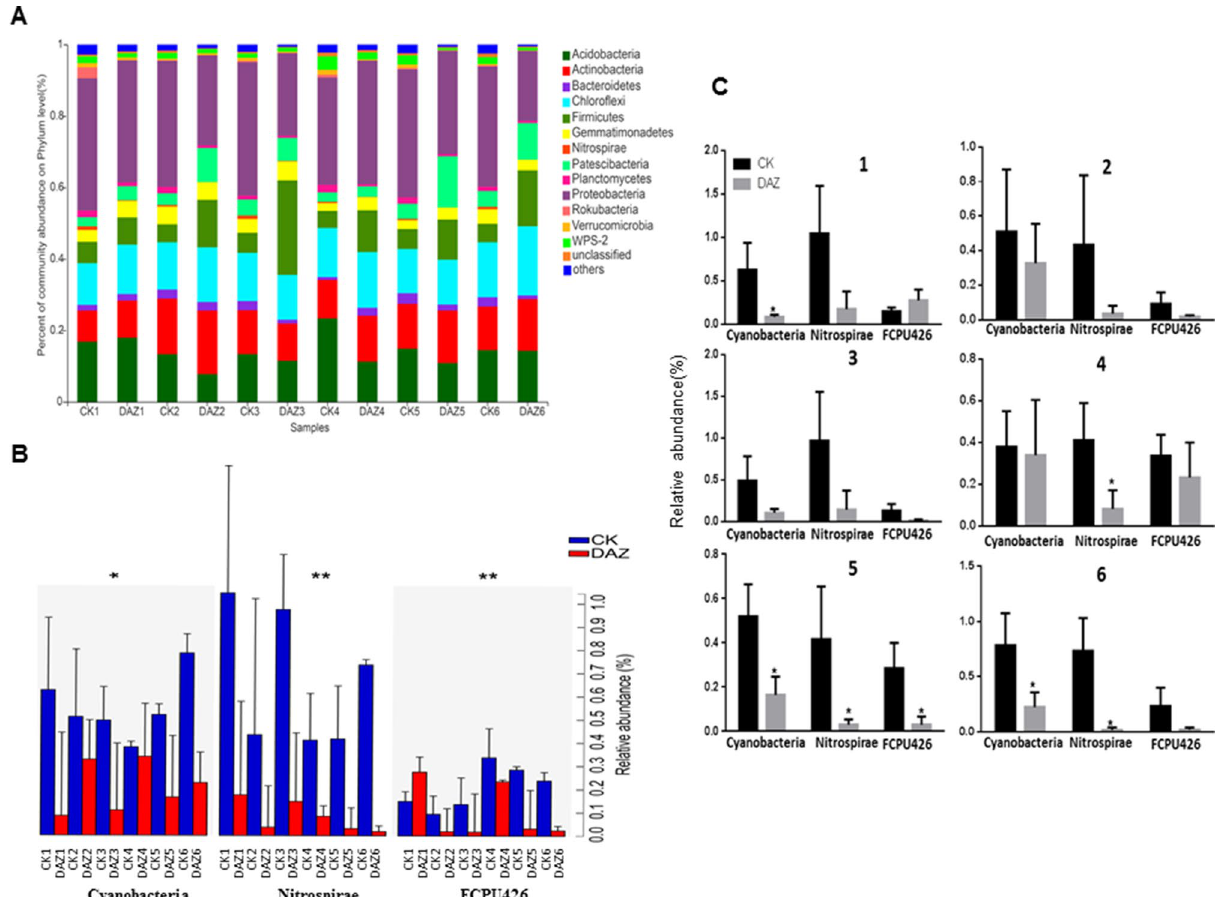
Figure 3. Dynamic changes of dominant bacterial community analyses on phylum level. ( A ) Community bar plot analysis of soil bacterial community abundance in different sampling times on phylum level. ( B ) Kruskal– Wallis H test was used to test the significance of the dynamic changes of bacterial community relative abundance at different sampling times on phylum level. (C) Student’s t-test bar plot showed significant differences of the main bacterial phyla between treatment and CK. The X-axis represents the bacterial phylum, the Y-axis represents its average relative abundance. DAZ dazomet treatment, CK control. Numbers after letters indicate different sampling times. 1 (March 6th, 2018, before dazomet treatment), 2 (April 24th, 2018, watermelon seedling stage), 3 (May 3rd, 2018, Fusarium wilt symptom appearance), 4 (March 6th, 2019, before dazomet treatment), 5 (April 22th, 2019, watermelon seedling stage), 6 (April 29th, 2019, Fusarium wilt symptom appearance). Data are expressed as the means ± SD (n = 3). * 0.01 < P ≤ 0.05, ** 0.001 < P ≤